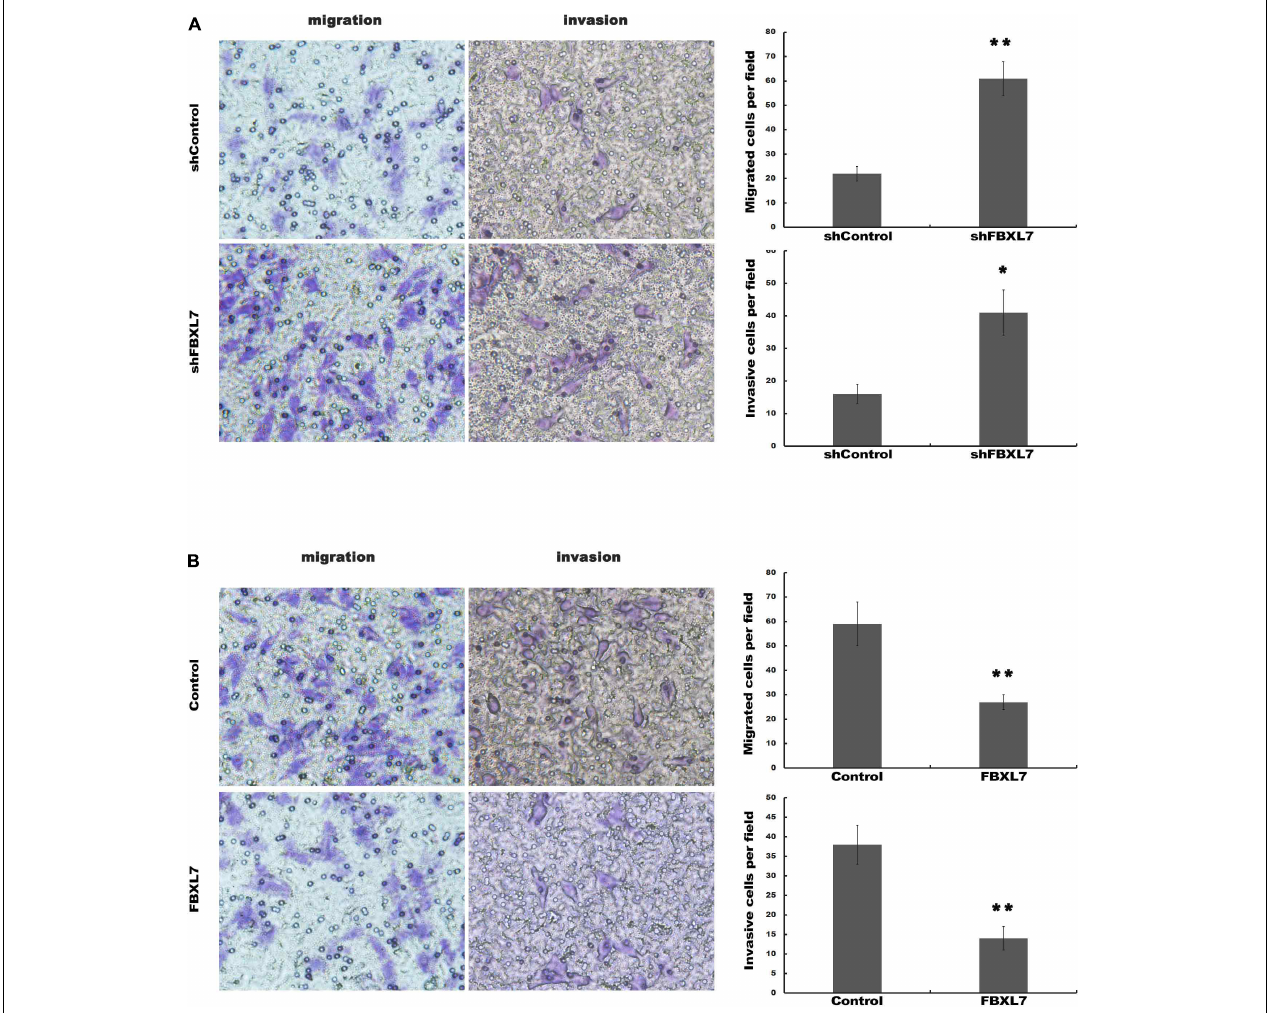
FIGURE 3 | FBXL7 inhibition enhanced migration and invasion of PCa cells. (A) The BxPC-3 cell migration and invasion were detected after shFBXL7 transfection by Transwell assay. (B) The PANC1 cell migration and invasion were detected after FBXL7 overexpression by Transwell assay. Data represent means ± SD of three independent experiments with significance determined by two-tailed Student’s t -test * P < 0.05, ** P <